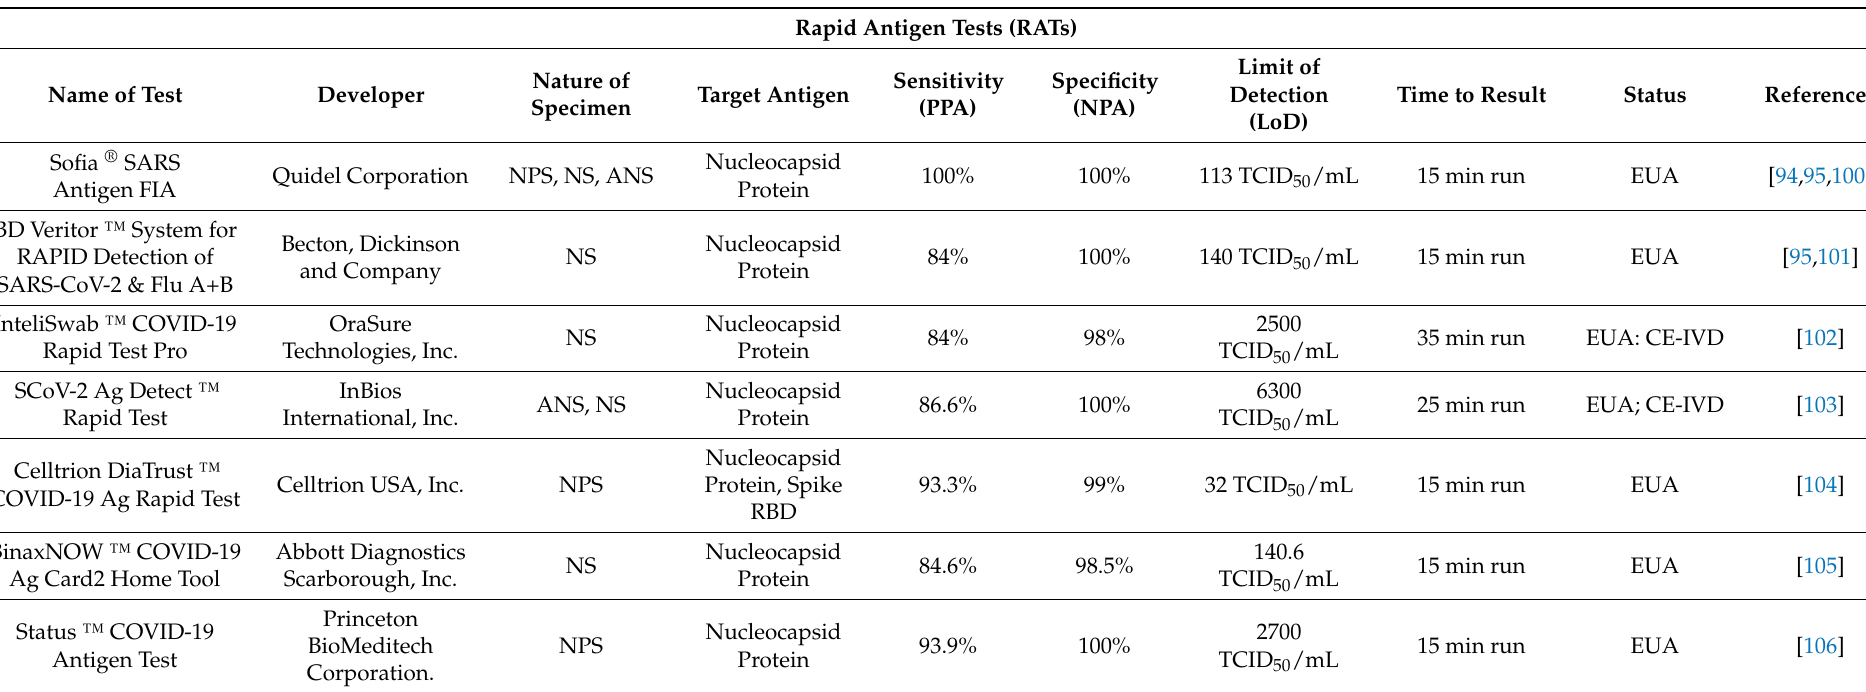
Table 2. Comparative list of rapid antigen tests for the detection of SARS CoV-2, by manufacturer, origin of specimen, target gene, sensitivity, specificity, limit of detection, and the time to produce one successful